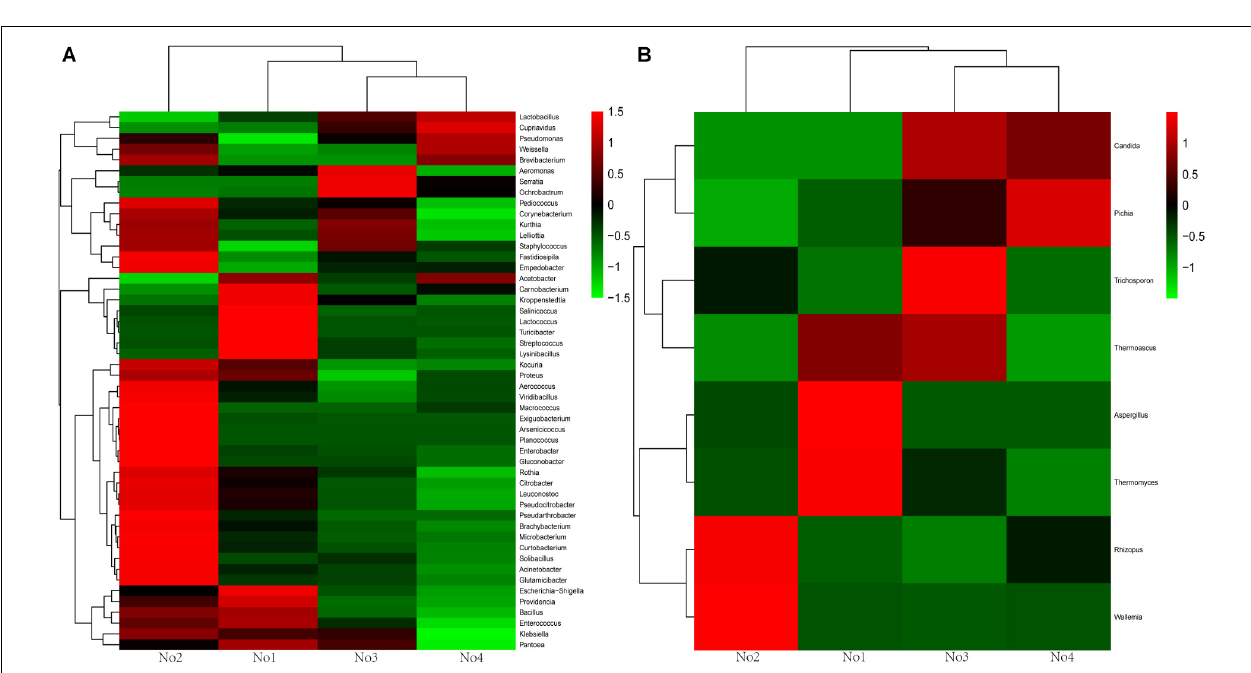
FIGURE 2 | Heat map of genera level community composition in combination with cluster analysis. (A) Bacteria heat map. (B) Fungi heat